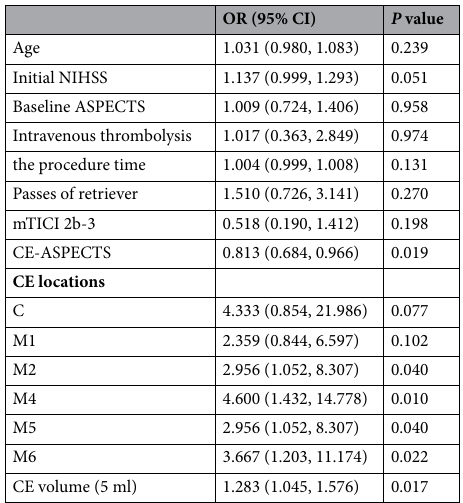
Table 2. Univariable logistic regression analysis of predictors for poor outcome. NIHSS National Institutes of Health Stroke Scale, CE contrast enhancement, ASPECTS Alberta stroke program early computed tomography score, C caudate nucleus, mTICI modified Thrombolysis in Cerebral Infarction, 95% CI indicates 95% confidence interval, OR odds ratio.